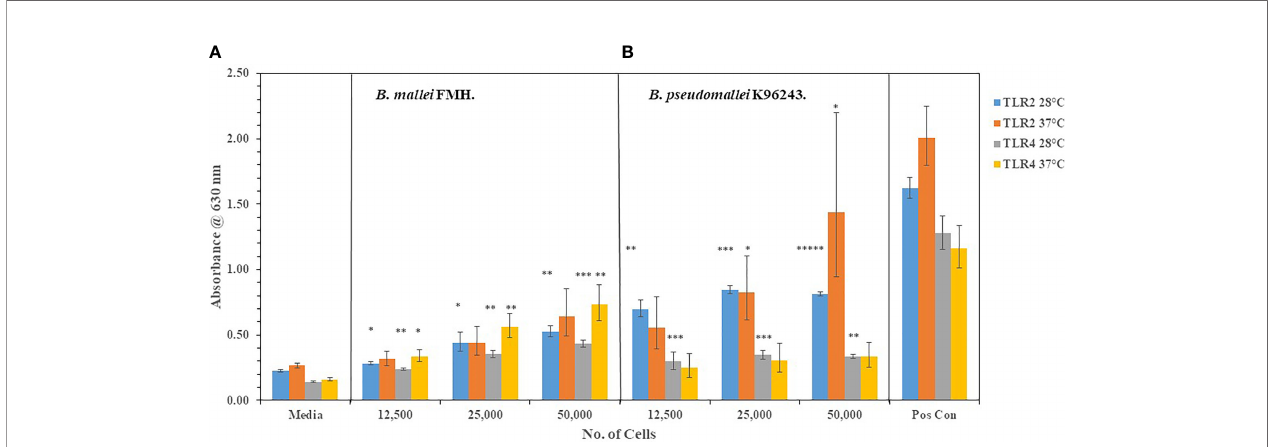
FIGURE 3 | Neither B. mallei nor B. pseudomallei K96243 suppress activation of TLR2 or TLR4 at 37°C. B. mallei (A) and B. pseudomallei K96243 (B) were grown at 28°C or 37°C for ~48 h, and bacterial suspensions were diluted in PBS to inoculate HEK293-TLR2 or -TLR4 cells. Media controls contained only PBS rather than bacterial cells and positive controls contained either HKLM cells (2 x 10 6 cells) for TLR2 or E. coli LPS (0.2 ng) for TLR4. All samples were analyzed in triplicate, and results represent one of two independent repeats. Samples were read at 630 nm after ~20 h of incubation. Results are presented as geometric mean with standard error of the mean. Signi fi cant values compared to media control are shown: * P ≤ 0.05; ** P ≤ 0.0100; *** P ≤ 0.0010; ***** P ≤